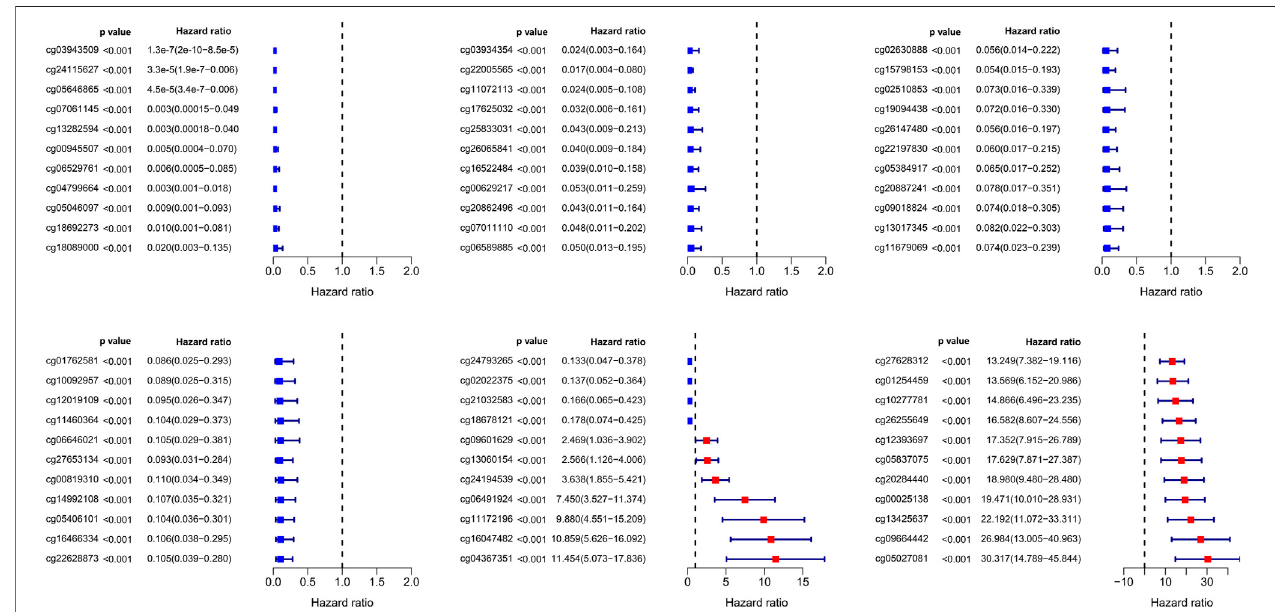
FIGURE 2 | Signi fi cance and hazard ratio values of 66 independent prognosis-related CpG loci obtained from multivariate Cox regression